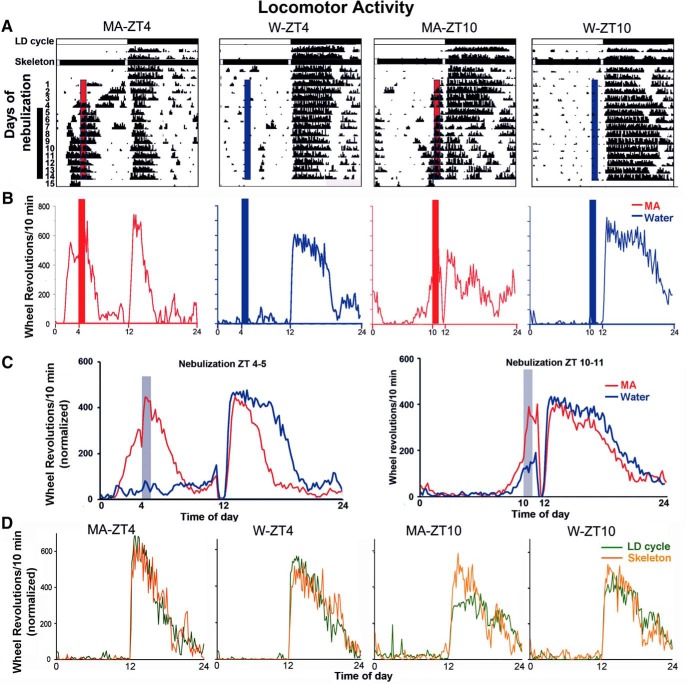
Locomotor activity of mice in each experimental group. A, Actograms of individual mice show the locomotor activity of representative animals in each group; access to nebulized MA or W for 1 h at ZT4 or at ZT10. Animals were housed in a LD cycle and then in a skeleton photoperiod. The LD cycle and skeleton photoperiods are shown by the horizontal bars in which white denotes day and black denotes night. The vertical black bar on the left of the y-axis shows the days used for analysis of locomotor activity. The vertical red (MA) or blue (W) bars within the actograms show the time of daily opening of the tunnel door at either ZT4–ZT5 or ZT10–ZT11 on nebulization days 1–14. B, For individual animals depicted in the actograms in A, locomotor activity is shown for each 10-min interval, averaged over days 5–14. C, For all animals in each group, locomotor activity for each 10-min interval was averaged over days 5–14. For comparisons among groups, activity level of each animal is normalized (see methods) to control for differences among individuals in daily amount of running. D, Comparison of activity during the 3-d LD cycle shown in the actogram in A and the following 2-d skeleton photoperiod. Analysis was performed as in C. The results indicate that the phase of entrainment to LD was not changed when the full photoperiod was replaced by a skeleton photoperiod.